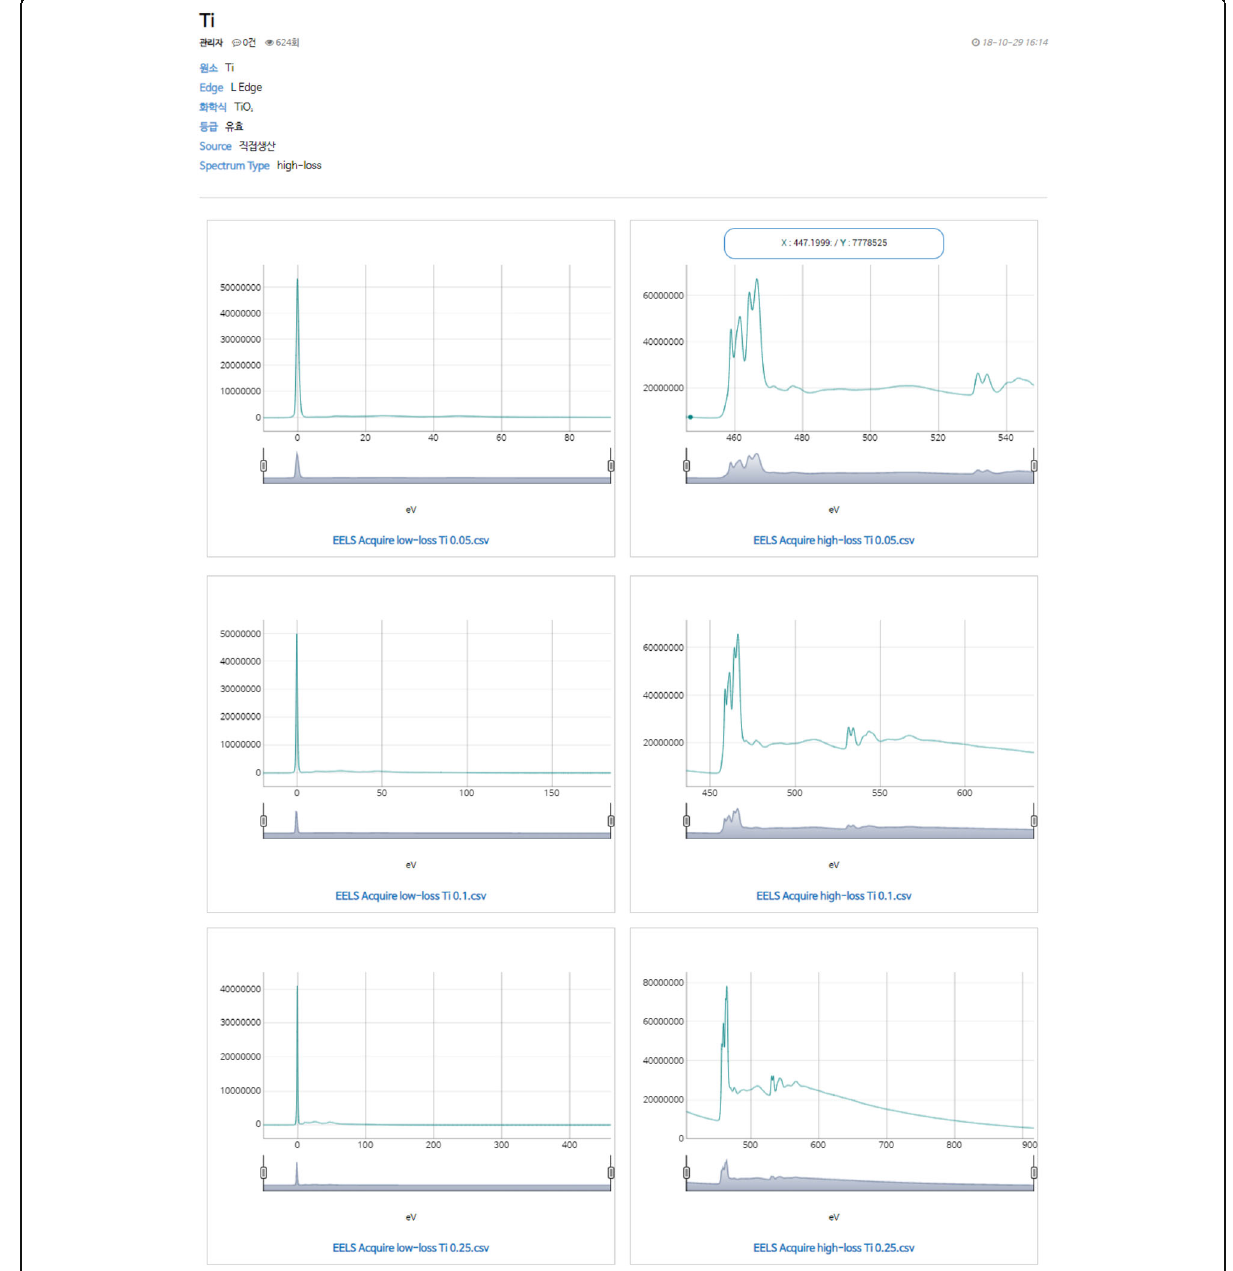
Fig. 4 EEL standard reference spectra of Ti-L edge of TiO 2 with the 0.05, 0.1 and 0.25 eV dispersion. CSV files can be downloaded by clicking the blue name below each (Table 1). In the spectrum information, specifically onset energy and measurement uncertainty values for data reliability and accuracy are provided.